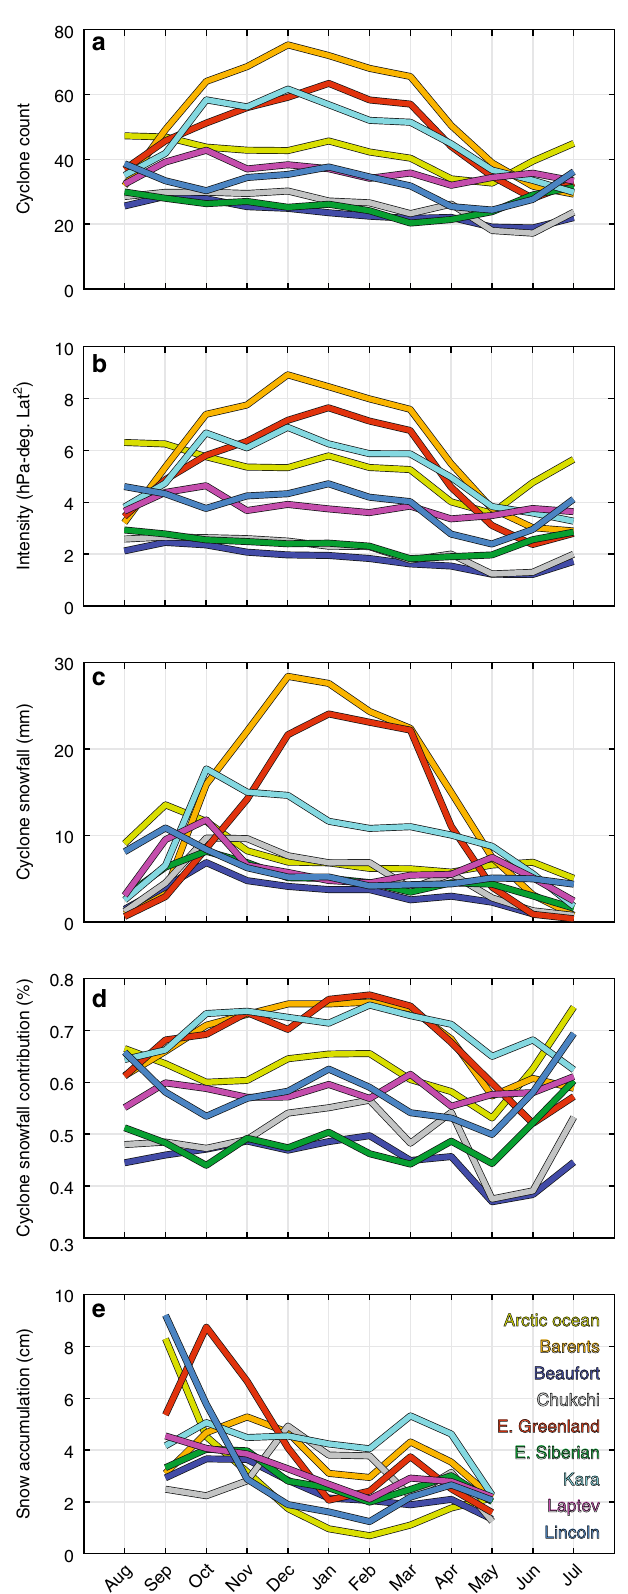
Fig. 3 The 1979 – 2016 monthly mean in the seasonal cycle of cyclone variables and snow accumulation. Monthly averages of a cyclone count, b intensity, c cyclone snowfall, d cyclone-snowfall contribution, and e snow accumulation in nine distinct